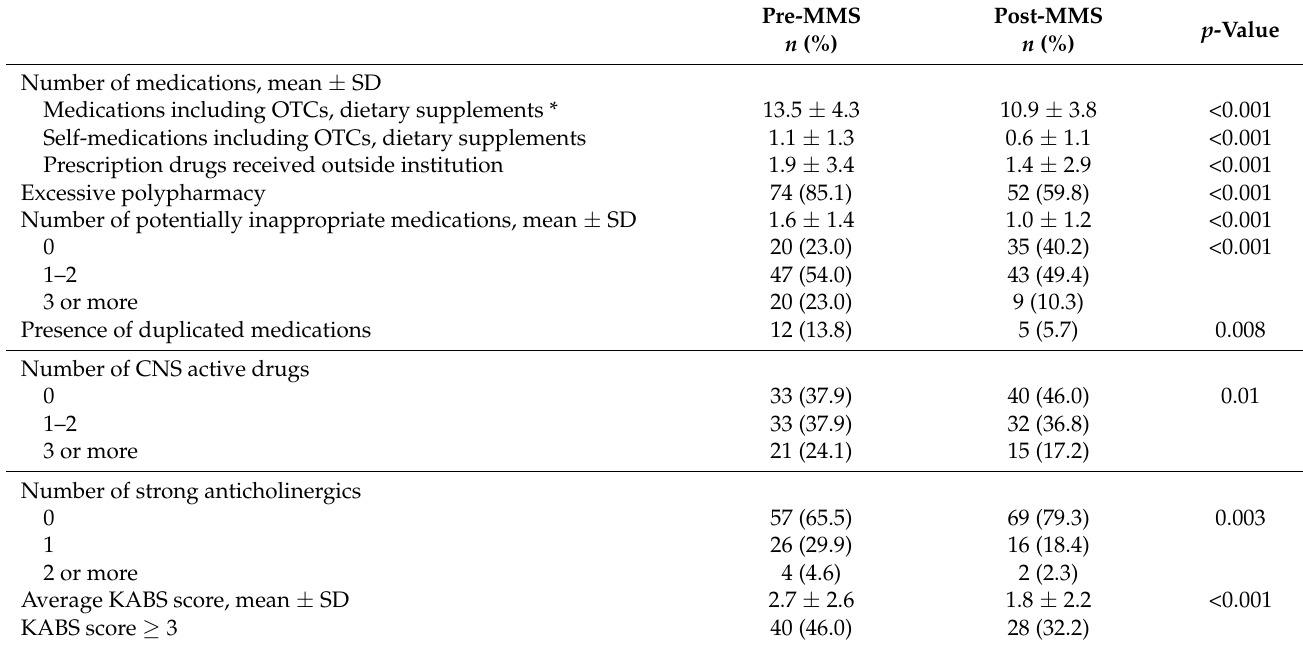
Table 2. Changes in quality of medication use in patients undergoing geriatric medication management service (MMS) (N = 87).